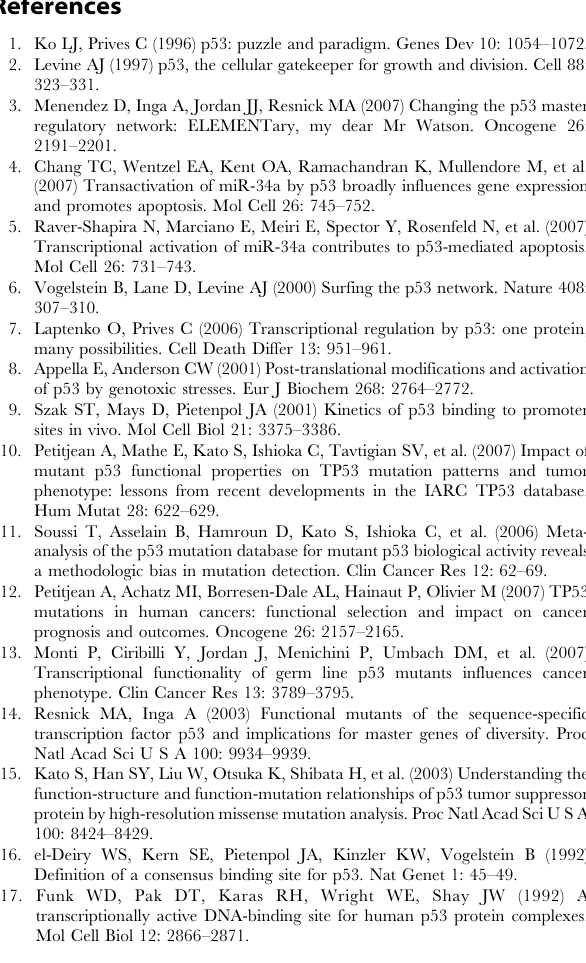
Table S1 Response element